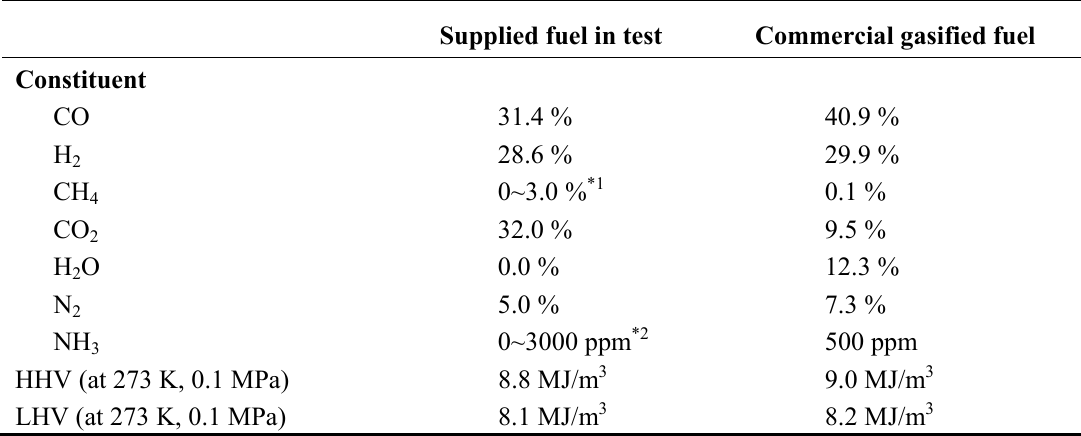
Table 8. Comparison of supplied fuel in tests and typical case of commercial gasified